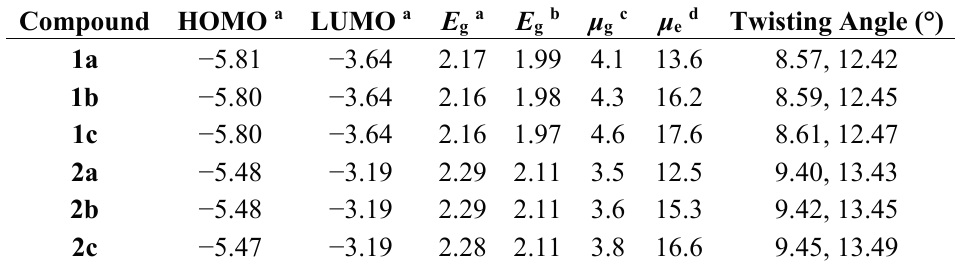
Table 4. Calculated and experimental parameters for 1a – 1c and 2a – 2c